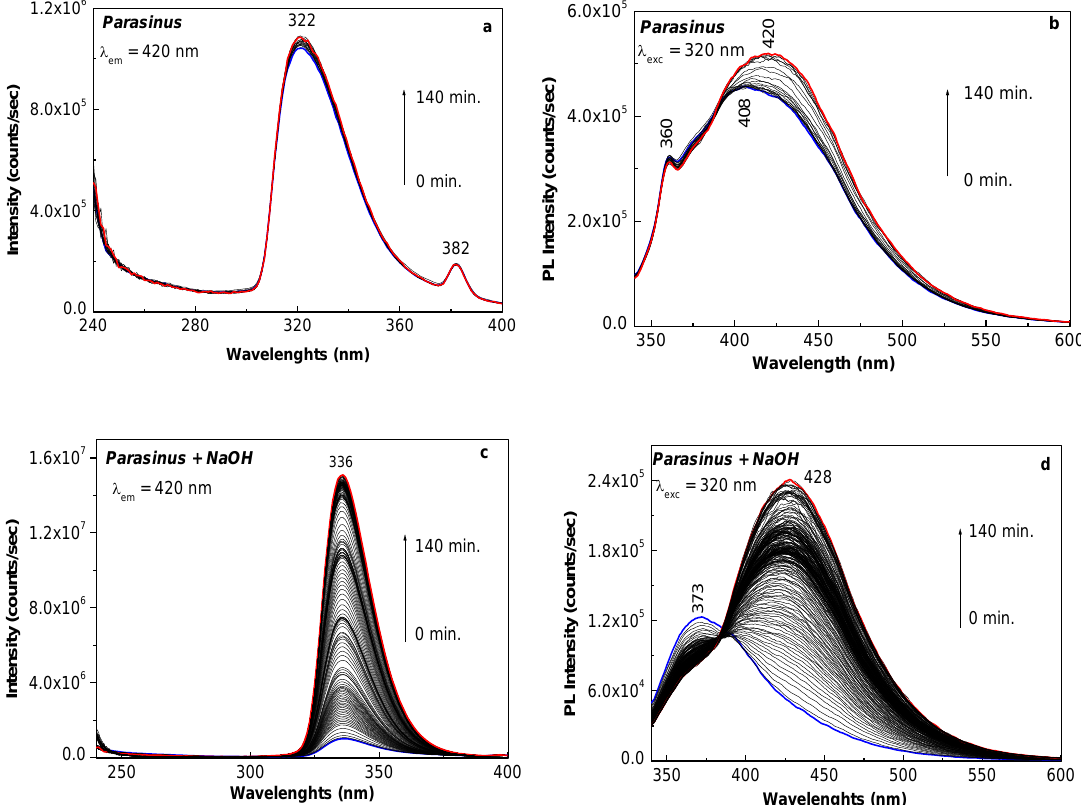
Figure 4. The PLE and PL spectra of the aqueous solution of Parasinus before ( a , b ) and after the interaction with the aqueous solution of NaOH 3 × 10 − 1 M ( c , d ). Blue and red curves correspond to the first and last spectrum, respectively, of the samples exposed at UV light for 0 and 140 min. Black curves correspond to the intermediate spectra of above samples, each PLE and PL spectrum being collected at 84 and 140 s, respectively.